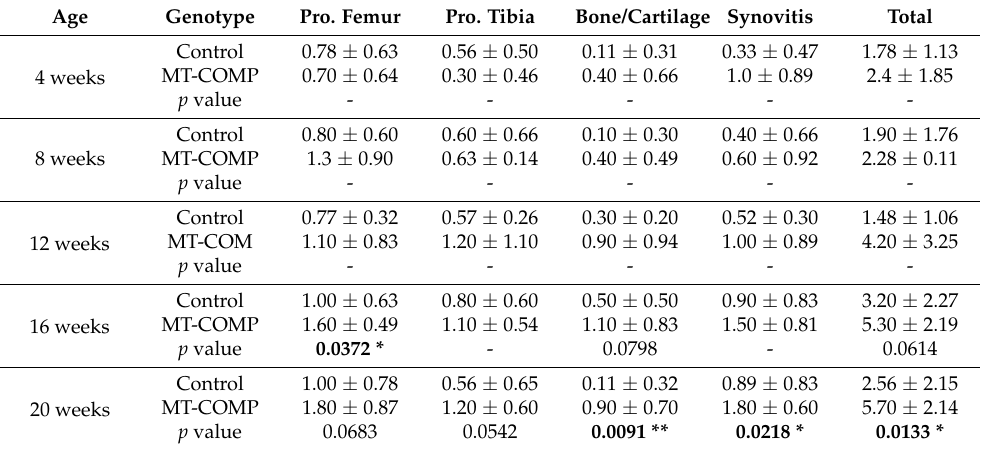
Table 1. OA score for MT-COMP and control